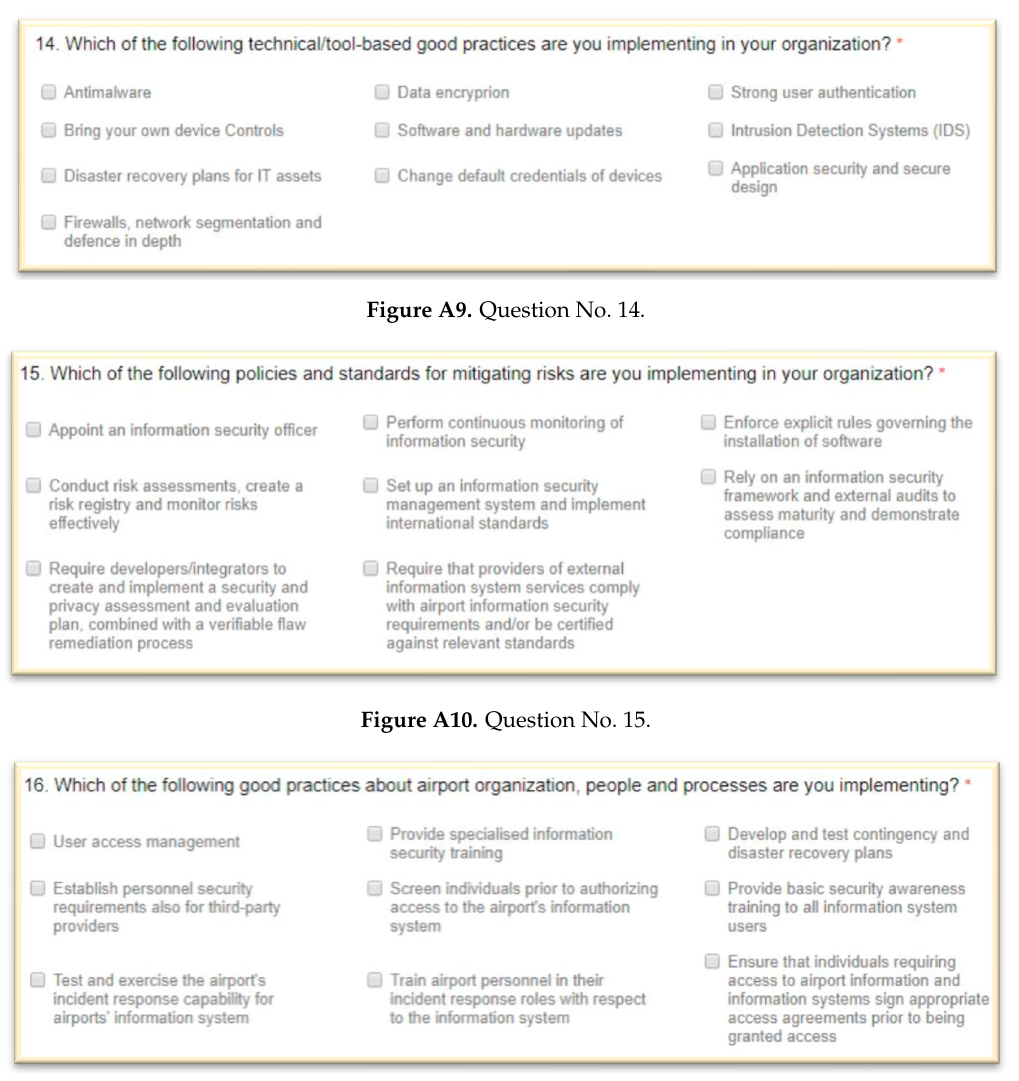
Figure A8. Question No 13.